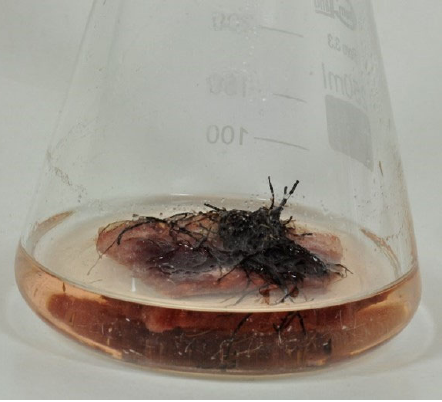
Figure 6. 28th day in vitro culture of R. graeca roots immobilized on polyurethane foam raft. Chromatographic analysis showed that irrespective of the root line, in control unmod- ified cultures rinderol was not detected in both root biomass and post-culture